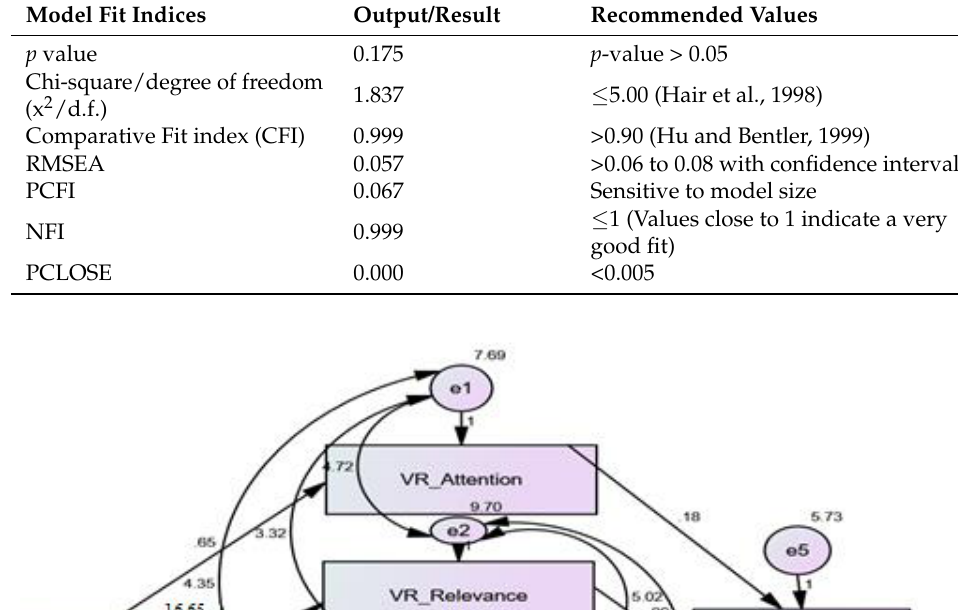
Table 4. Model fit summary of structural equation model.